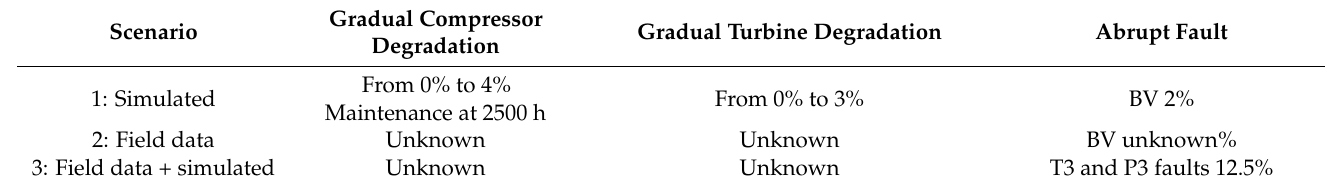
Table 3. Test scenarios.